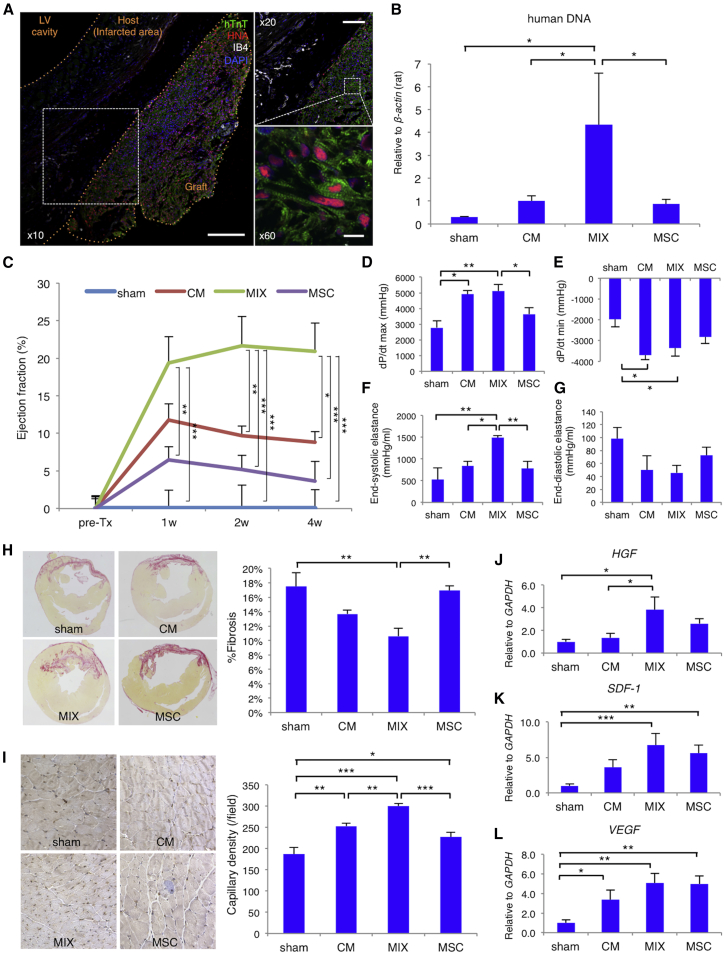
Combination of hiPSC-CMs and hMSCs Enhanced Therapeutic Effects In Vivo(A) Immunohistochemistry of human troponin T (hTnT; green), human nuclei (HNA; red), isolectin B4 (IB4; white), and nuclei (DAPI; blue) in a rat transplanted with a cell sheet containing both differentiated cardiomyocytes and MSCs (MIX) 4 weeks after cell sheet transplantation. Scale bars: 200 μm (left); 100 μm (right, top); 10 μm (right, bottom). (B) Expression of human DNA in the whole hearts of rat given no transplant (sham) or transplanted with a CM sheet, a MIX sheet, or an MSC sheet, normalized against rat β-actin expression. (C) Serial changes in the relative left ventricular ejection fraction in each group compared with sham rats, analyzed by transthoracic echocardiography (n = 10 for each group). pre-Tx, pre-transplantation; w, weeks after transplantation. (D–G) The dP/dt max (D), dP/dt min (E), end-systolic elastance (F), and end-diastolic elastance (G) in each group, analyzed by cardiac catheterization. (H) Left panels display representative images of myocardial fibrosis in each group, as assessed by Sirius Red staining. Right graph shows the percentage of fibrotic to myocardial tissue in each group (n = 8 for each group). (I) Left panels display representative images of immunohistochemistry of von Willebrand factor in each group. Right graph shows the capillary density per unit area in each group (n = 8 for each group). (J–L) Expression of the hepatocyte growth factor (HGF) (J), stromal cell-derived factor 1 (SDF-1) (K), or vascular endothelial growth factor (VEGF) (L) genes in each group, normalized against GAPDH expression (n = 8 for each group). For all experiments, one-way ANOVA with post hoc Tukey’s HSD test is used, and results are shown as mean + SEM. *p < 0.05; **p < 0.01; ***p < 0.001.